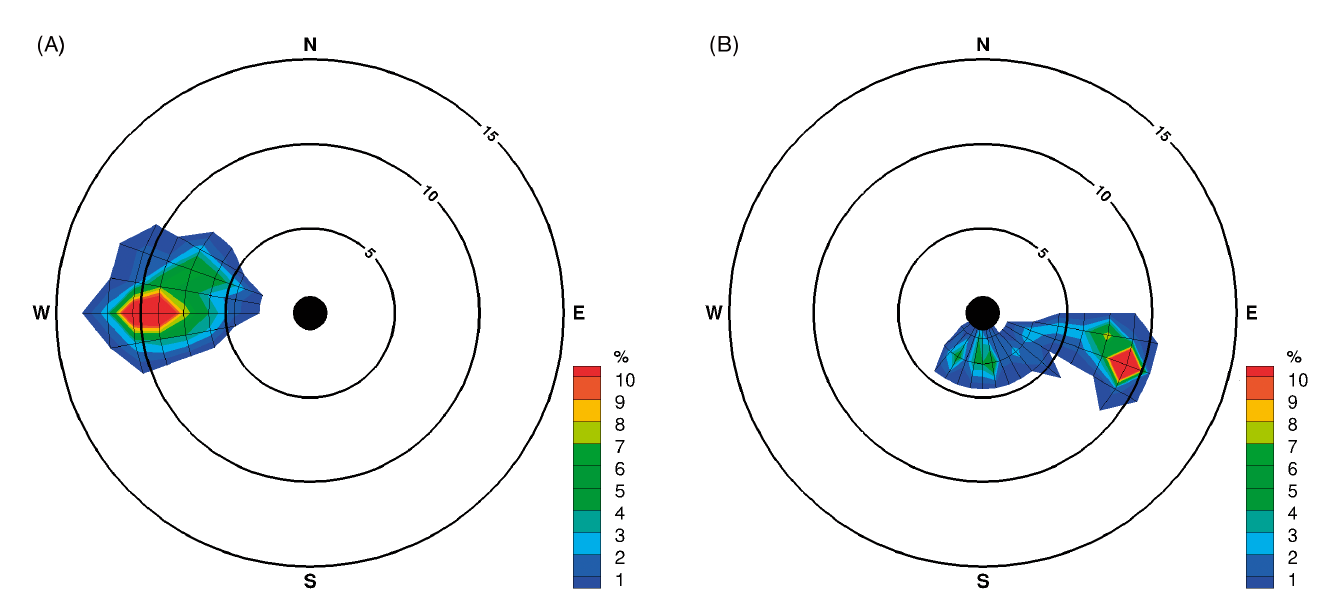
Fig. 3. Frequency plot of wind direction and speed (in 10° and 1.5 m s −1 intervals, respectively) during the 12 h period prior to the spatial surveys in (A) November 2013 and (B) February 2014